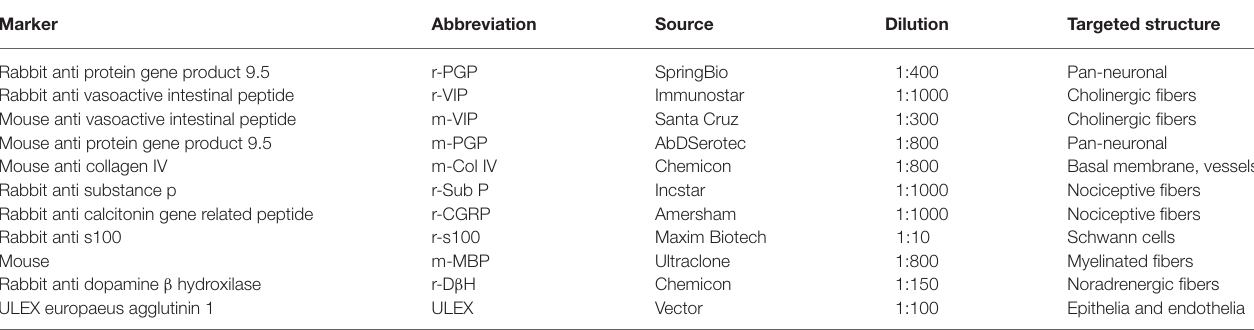
TABLE 1 | Abbreviation, source and dilution of immunohistochemical markers. Marker Abbreviation Rabbit anti protein gene product